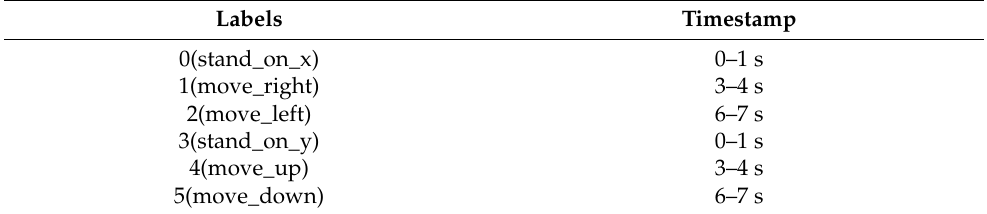
Table 2. Labeling